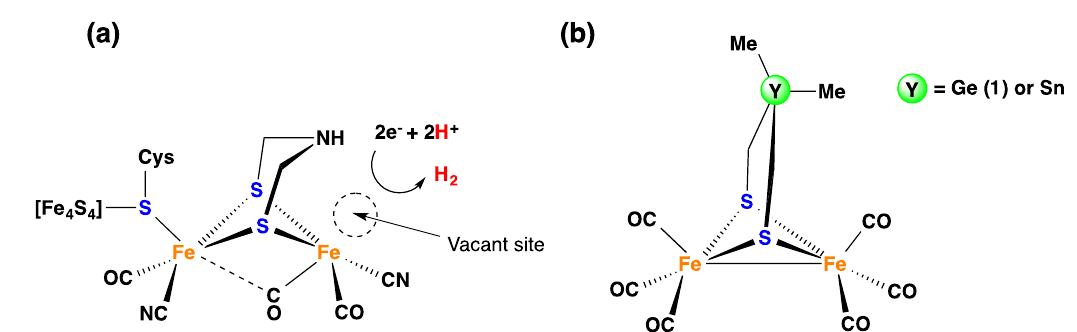
Figure 1. ( a ) The H-cluster of the [FeFe]-Hydrogenase. ( b ) Mimics of the H-cluster containing heavier group 14 atoms at the bridgehead position (Y) of the dithiolato ligand [–SCH 2 YCH 2 S–] (Y = GeMe 2 (complex 1 ) or SnMe 2 ).